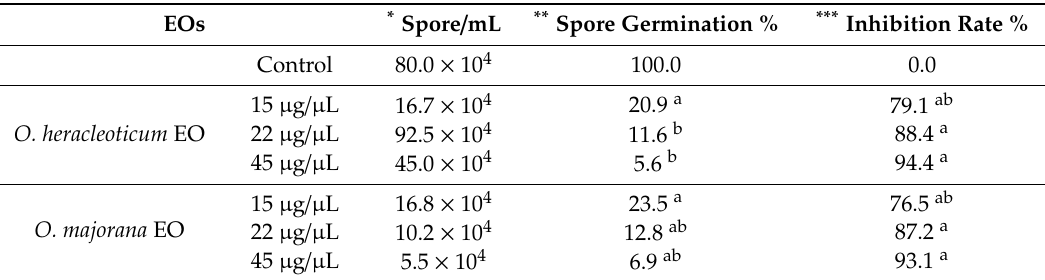
Table 3. Evaluation the effect of O. heracleoticum and O. majorana EOs on the spore germination of Monilinia fructicola.